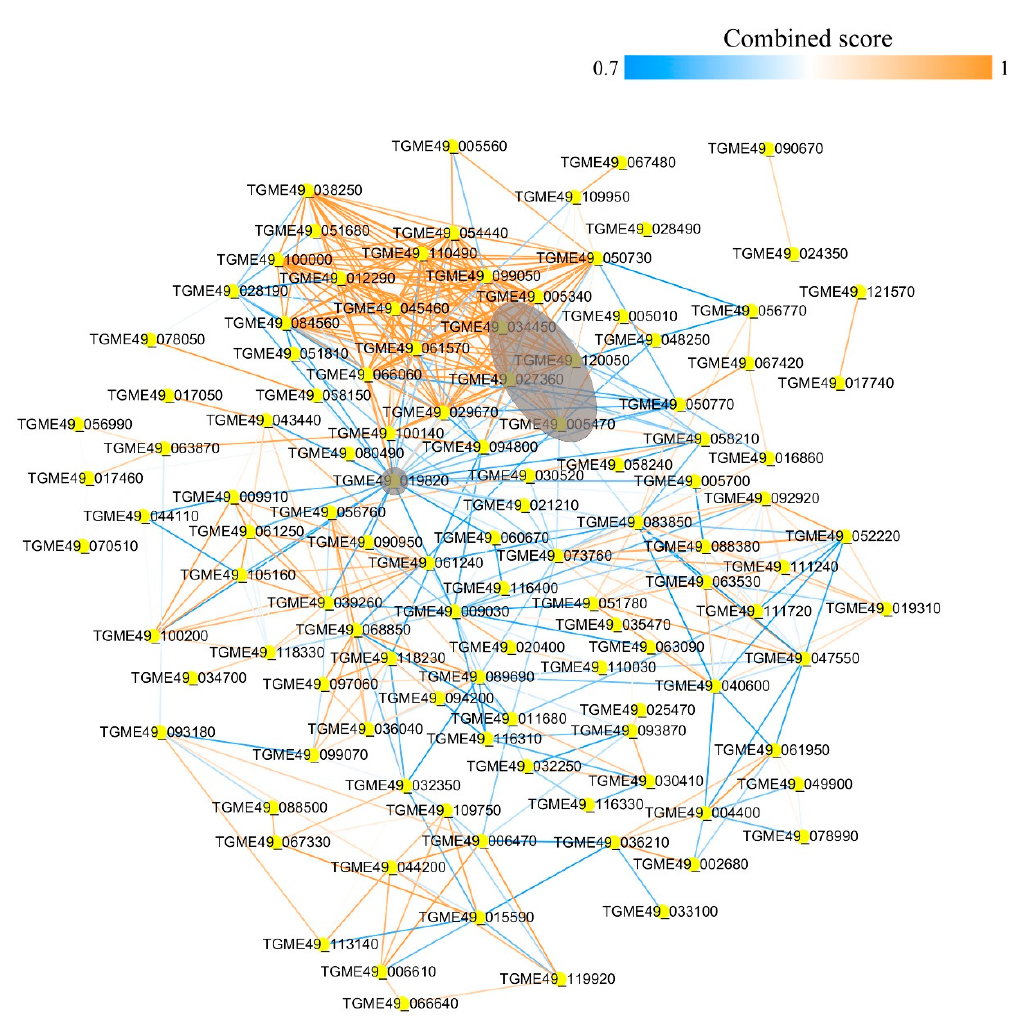
Figure 6. Protein–protein interaction network of the acetylated proteins in PYS strain. Nodes represent the acetylated proteins and edges represent interactors between acetylated proteins. The color of the edge denotes the combined score of interactors. The grey color indicates the major / hub nodes of the protein-protein interaction network.